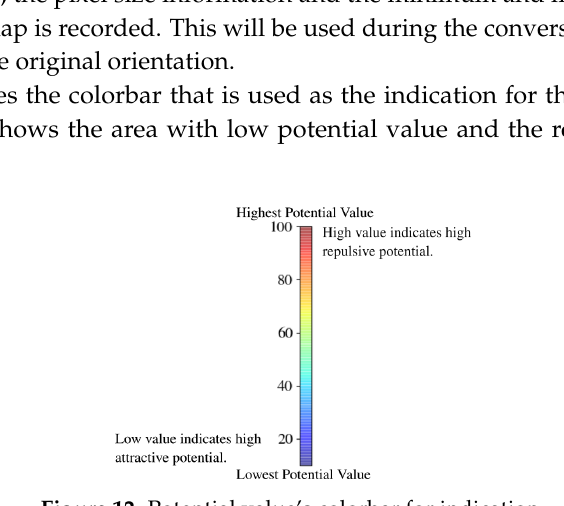
Figure 12. Potential value’s colorbar for